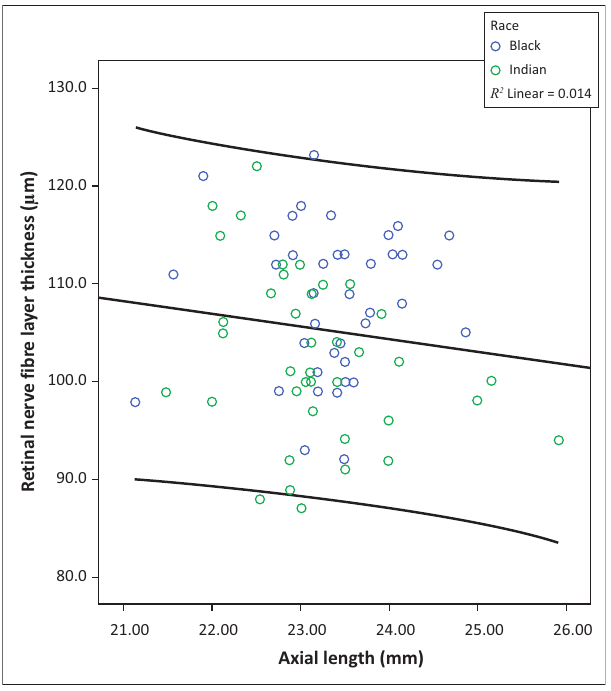
FIGURE 3: Scatter plot showing the relationship of axial length and global retinal nerve fibre layer thickness (for the total sample) with 95 % confidence interval of the regression line ( R 2 = 0.01, r = -0.12, p = 0.30).